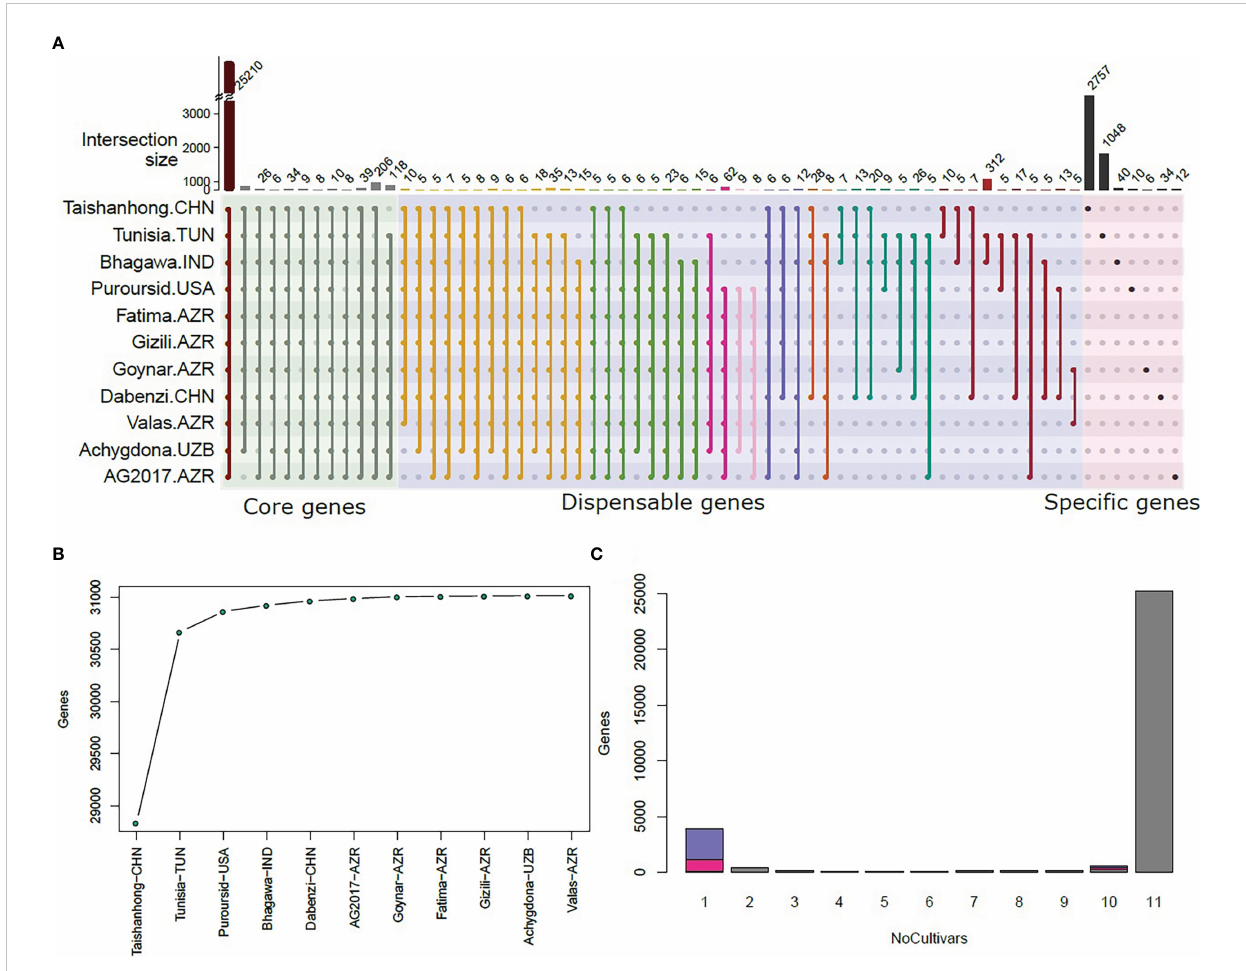
FIGURE 2 The pan-genome of pomegranate. (A) Histograms showing the core gene clusters (present in at least nine genomes), dispensable gene clusters (present in two to eight genomes), and lineage-speci fi c genes (present in a single cultivar). Only combinations that have fi ve genes or more were plotted; (B) the increase of the number of genes with increasing the number of cultivars; (C) the total number of genes versus the number of cultivars in which they exist. For categories 1 and 9, purple and pink colors represent the number of genes that existed or did not exist in Taishanhong and Tunisia cultivars,